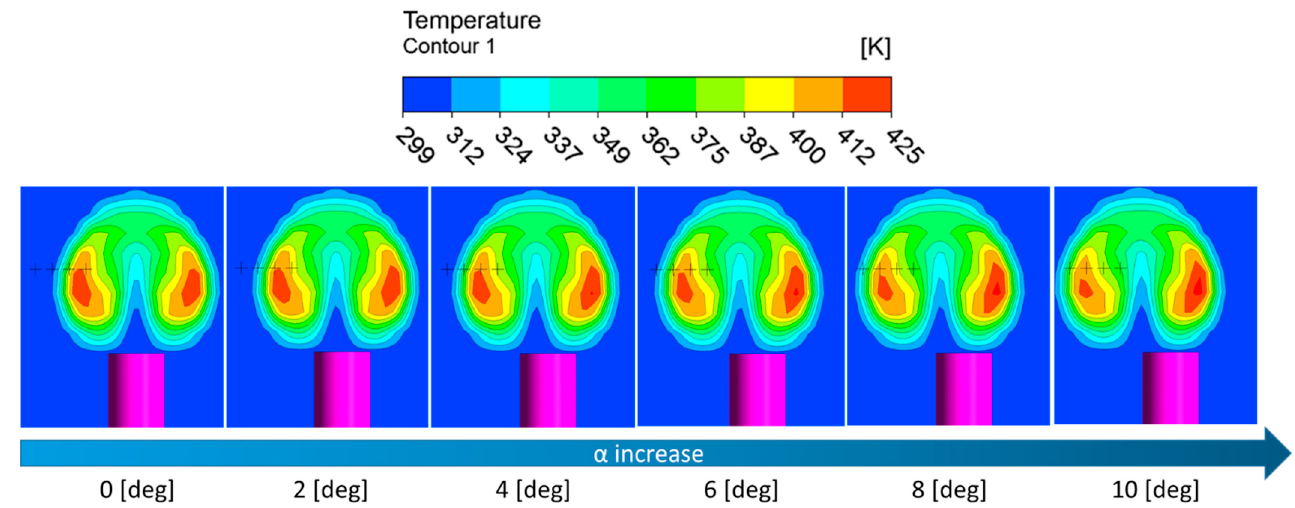
Figure 21. Temperature contours in a cross-section as a function of wind direction α .